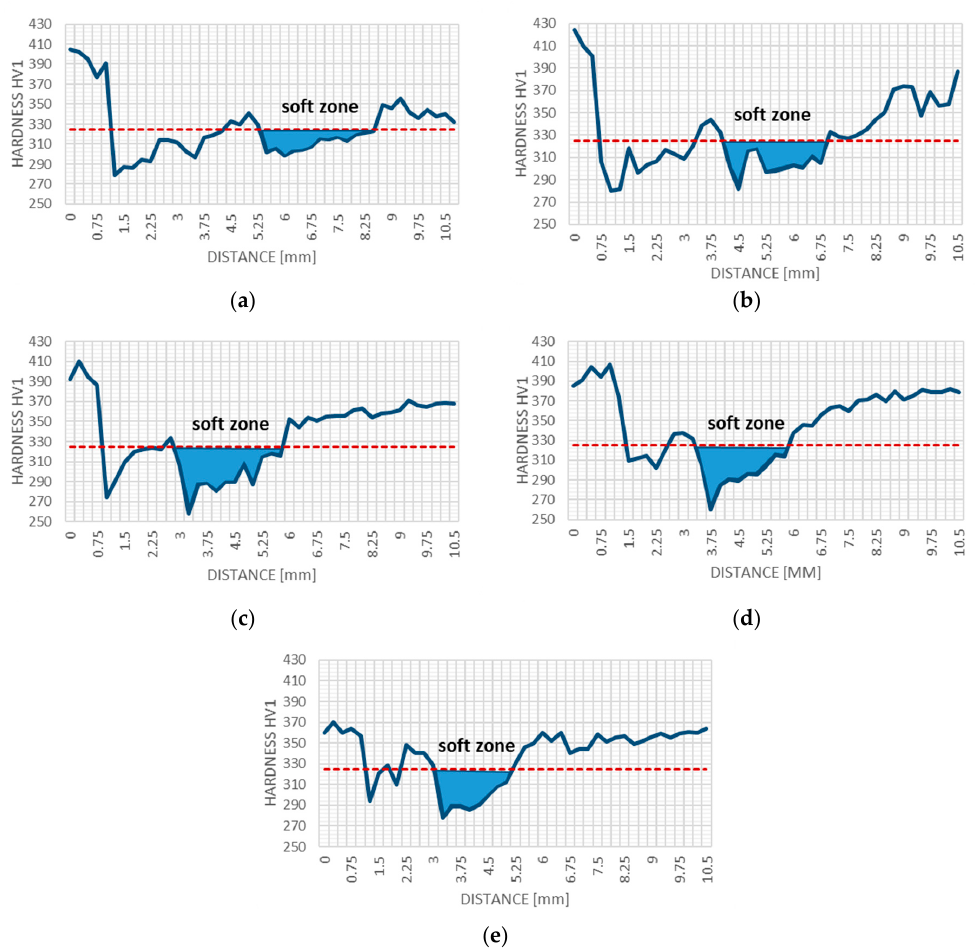
Figure 10. Determination of the soft zone width based on the microhardness measurements: ( a ) GMAW-S, ( b ) GMAW-P, ( c ) GMAW-CMT, ( d ) MCAW-S, and ( e ) MCAW-S cooled. HV1, hardness measurement performed by the Vickers method.